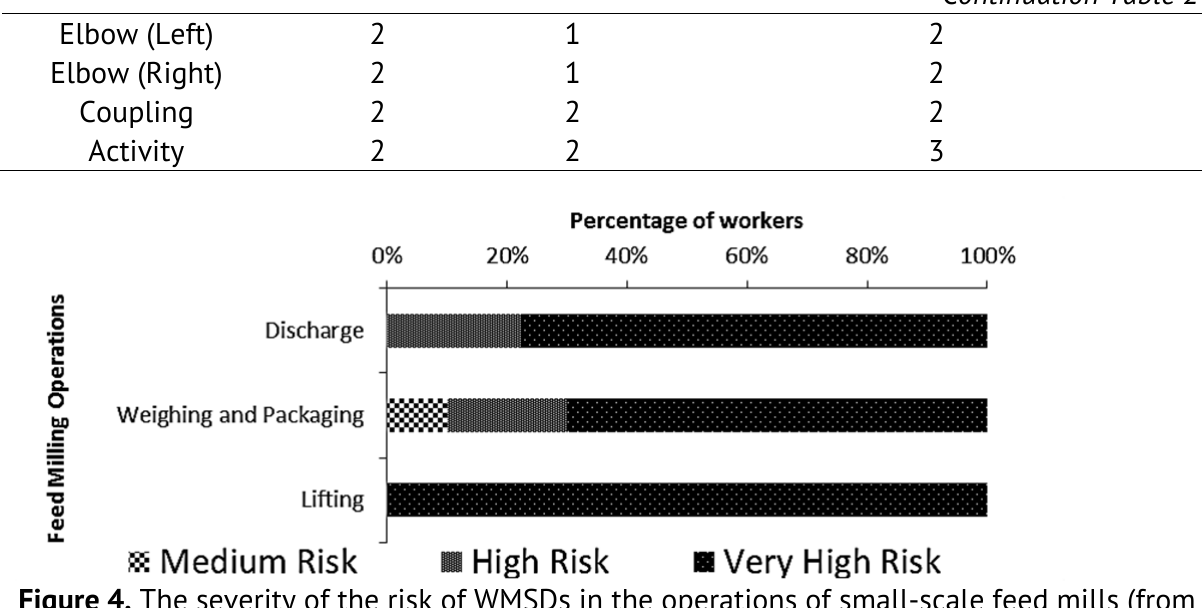
Figure 4. The severity of the risk of WMSDs in the operations of small-scale feed mills (from REBA scores).